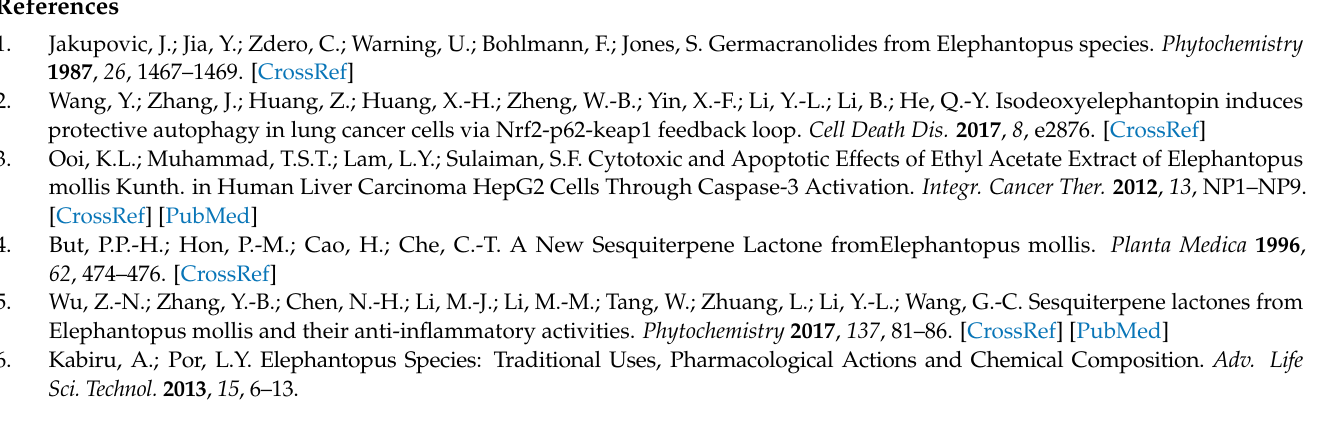
Figure S1: ESI-TOF-MS of compound 1., Figure S2: ESI-TOF-MS of compound 7., Figure S3: ESI- TOF-MS of compound 2., Figure S4: LC chromatogram of main fraction B., Figure S5: LC profile of subfraction C3 and ESI-TOF-MS of compound 4., Figure S6. LC chromatogram of sub-fraction P1C-C2-2P7., Figure S7. ESI-TOF-MS of peak VI., Figure S8. LC chromatogram of (a) peak VII and (b) peak XII., Figure S9. LC chromatogram of quinic acid derivations 8–10 and 22., Figure S10. LC chromatogram of crude extract P1E and MS profiles of sugars, Figure S11. MPLC chromatogram of fraction P1B., Figure S12. MPLC chromatogram of fraction P1C2., Figure S13. MPLC chromatogram of sub-fraction P1C2-2., Figure S14. MPLC chromatogram of sub-fraction